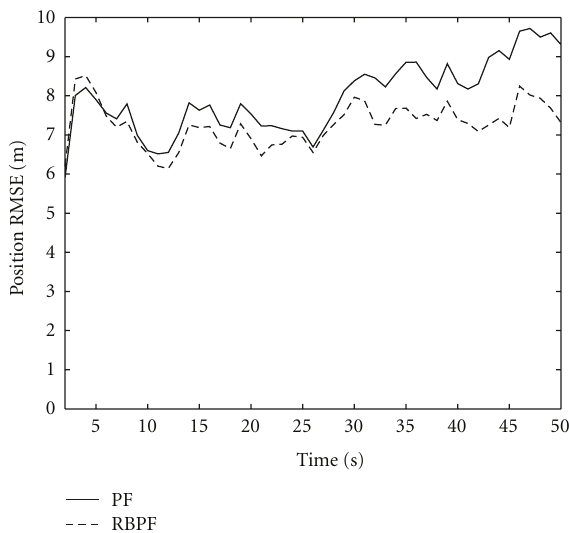
Figure 3: Position RMSE for the target tracking example using 100 Monte Carlo simulation with N = 2000 particles. The PF estimates are compared to those from the